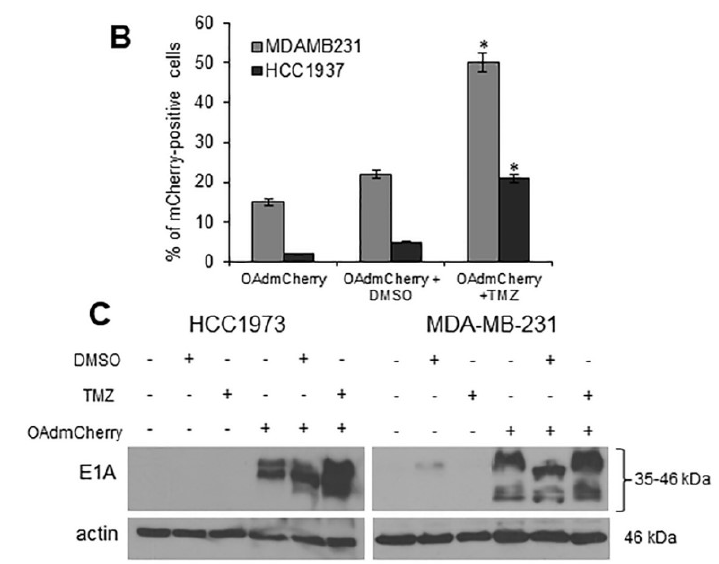
Figure 2. Effect of temozolomide (TMZ) treatment on virus infection and adenovirus early region 1A (E1A) expression in human triple-negative breast cancer (TNBC) cells: ( A ) Human TNBC cells were infected with oncolytic adenovirus mCherry (OAdmCherry) at a multiplicity of infection concentration of 2.5 alone or in combination with TMZ or vehicle dimethyl sulfoxide (DMSO). Expression of mCherry was evaluated by fluorescence microscopy. Scale: 200 µm. ( B ) Percentage of mCherry-positive cells calculated relative to number of cells in the field. Results represent the mean of three repeated measurements ± standard deviation (SD; error bars) (* p < 0.05). ( C ) Expression of Ad E1A was evaluated by Western blot assay at 24 h post treatment. Actin was used as a loading control. A representative assay is shown from three performed.